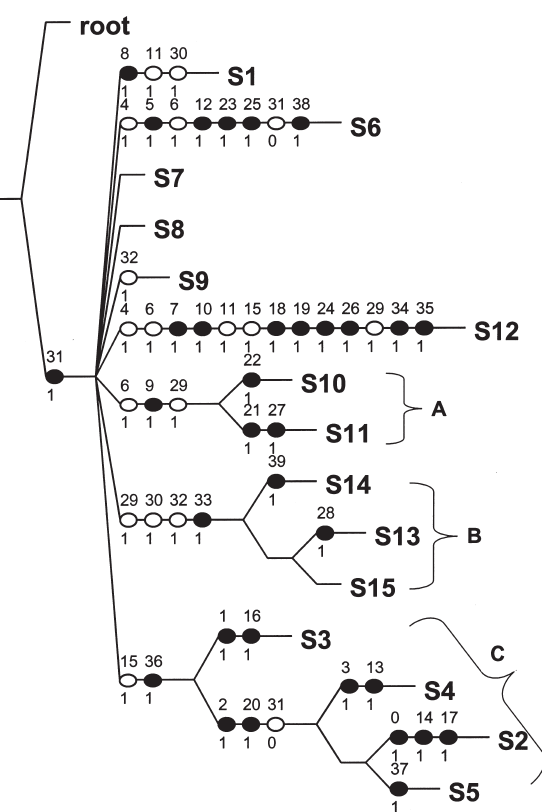
Fig. 2. – Strict consensus cladogram calculated from the Parsimony Analysis of Endemicity (PAE) showing the three areas of endemism. Area A with four sinapomorphies: (9) Ampelisca para- pacifica , (22) Hippomedon sp., (21) Liljeborgia sp., and (27) Perioculodes sp.; area B with three sinapomorphies: (33) Metharpinia floridana , (39) Syrrhoe sp., and (28) Halice sp., and area C with 11 sinapomorphies: (36) Stenothoe sp., (37) S . gallen- sis ., (0) Caprella sp., (1) C . danilevskii , (2) C . equilibra , (3) C . penantis , (16) Monocorophium acherusichum , (17) M . insidiosum , (13) Apocorophium acutum , (14) A . simile , and (20) Podocerus